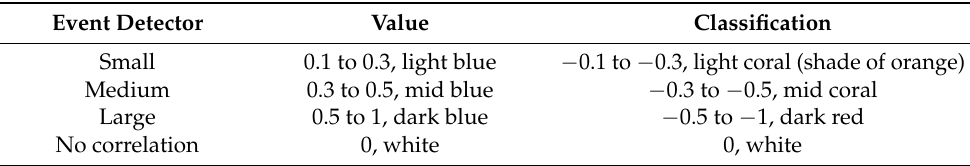
Figure 3. Correlation between enviroCar estimated fuel consumption and other variables (blue shades for positive correlation, red for negative). Table 1. Color code for the Pearson’s Correlation Coefficient .